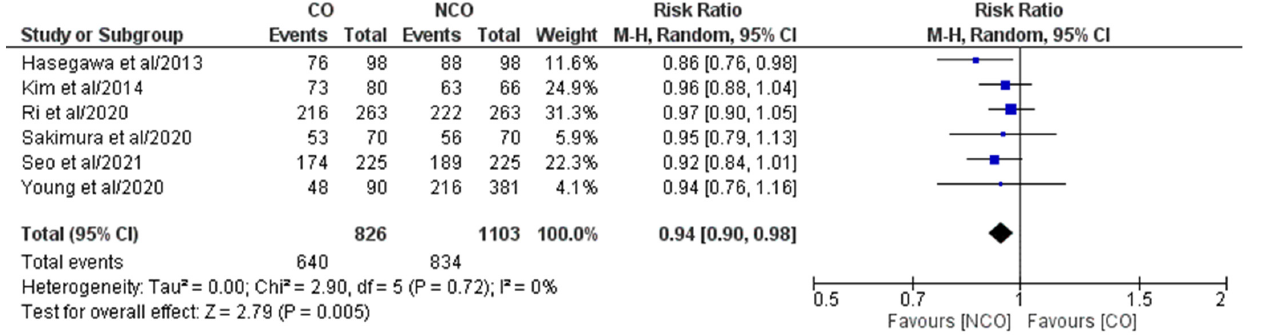
Figure 2. Forest plot comparing 3-year OS between the CO and NCO groups. CI, confidence interval; M–H, Mantel–Haenszel [16–21].